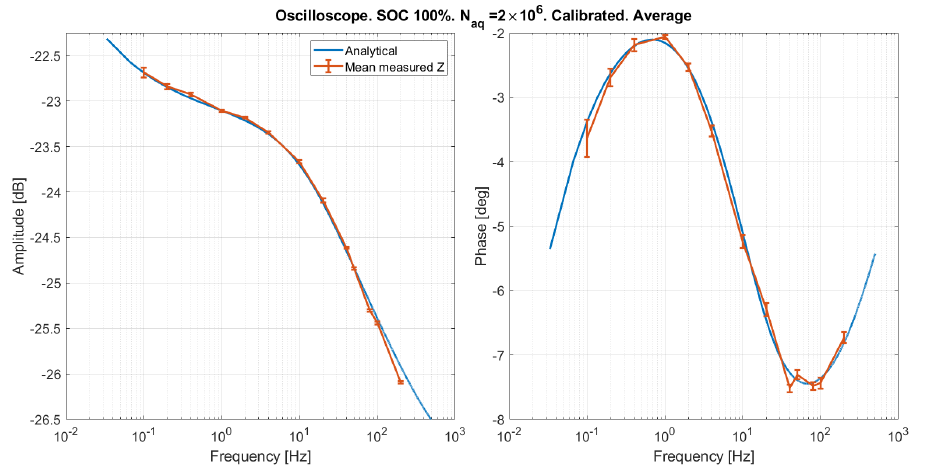
Figure 15. Mean and standard deviation over five repeated measurement of the emulated impedance.